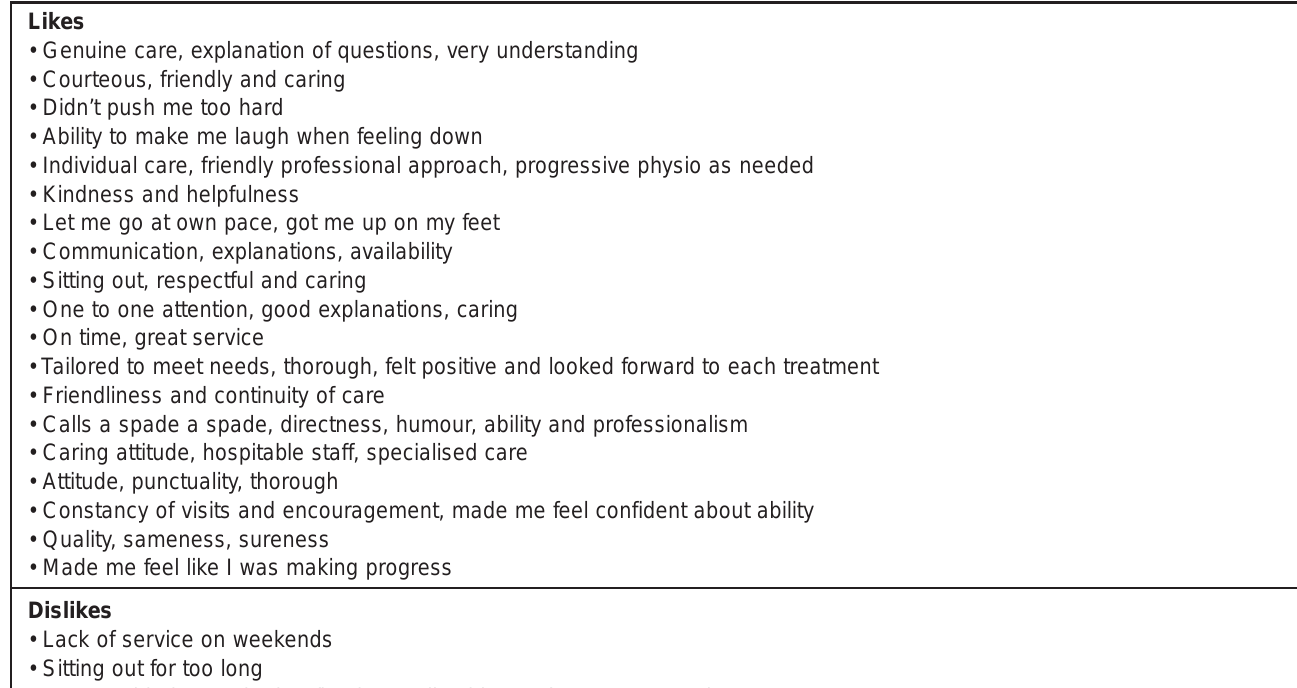
Table 2: Patients’ responses regarding likes and dislikes of the physiotherapy service in